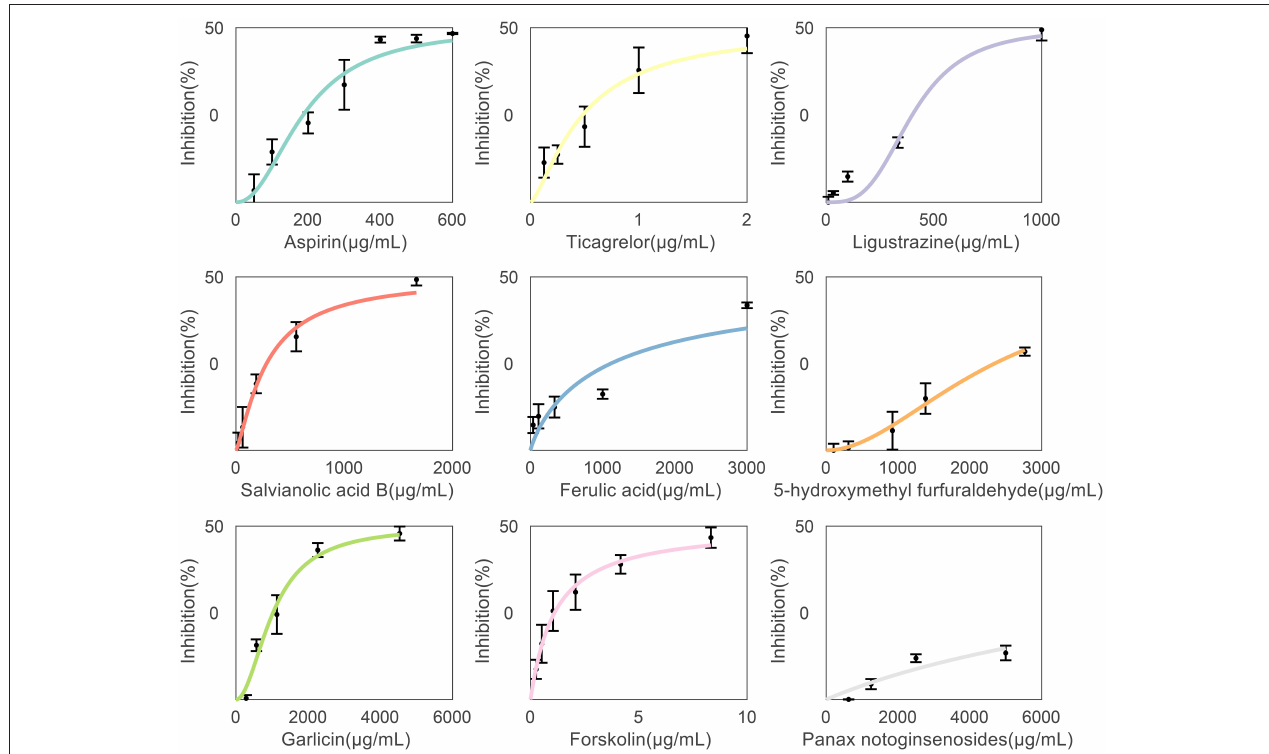
FIGURE 2 | Individual drug dose response curves. The anti-platelet activities of drugs were determined by checking their inhibiting effects on in vitro ADP-induced platelet aggregation of rat PRP. Shown were the experimental single drug dose response curves for the nine drugs used in this study. The curves were fitted using Hill equations, and the data was used to identify the drug concentrations to be used in combination studies.